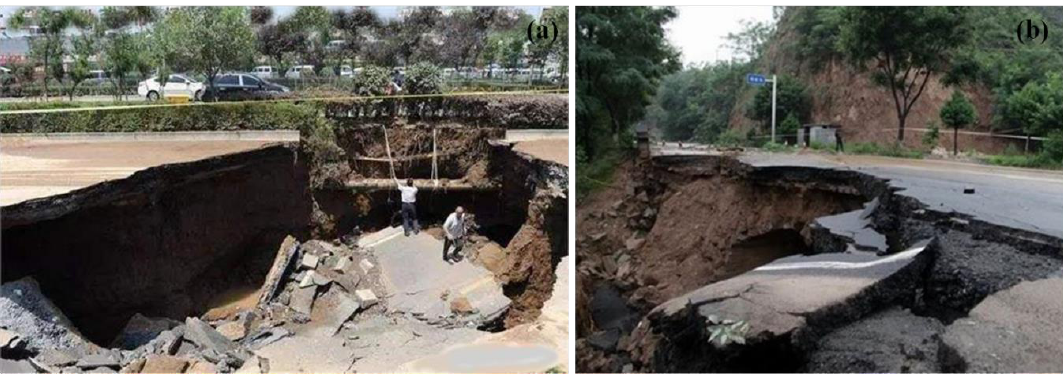
Figure 1. Geological disasters caused by water immersion of loess, ( a ) middle of the road, ( b ) side of the road.